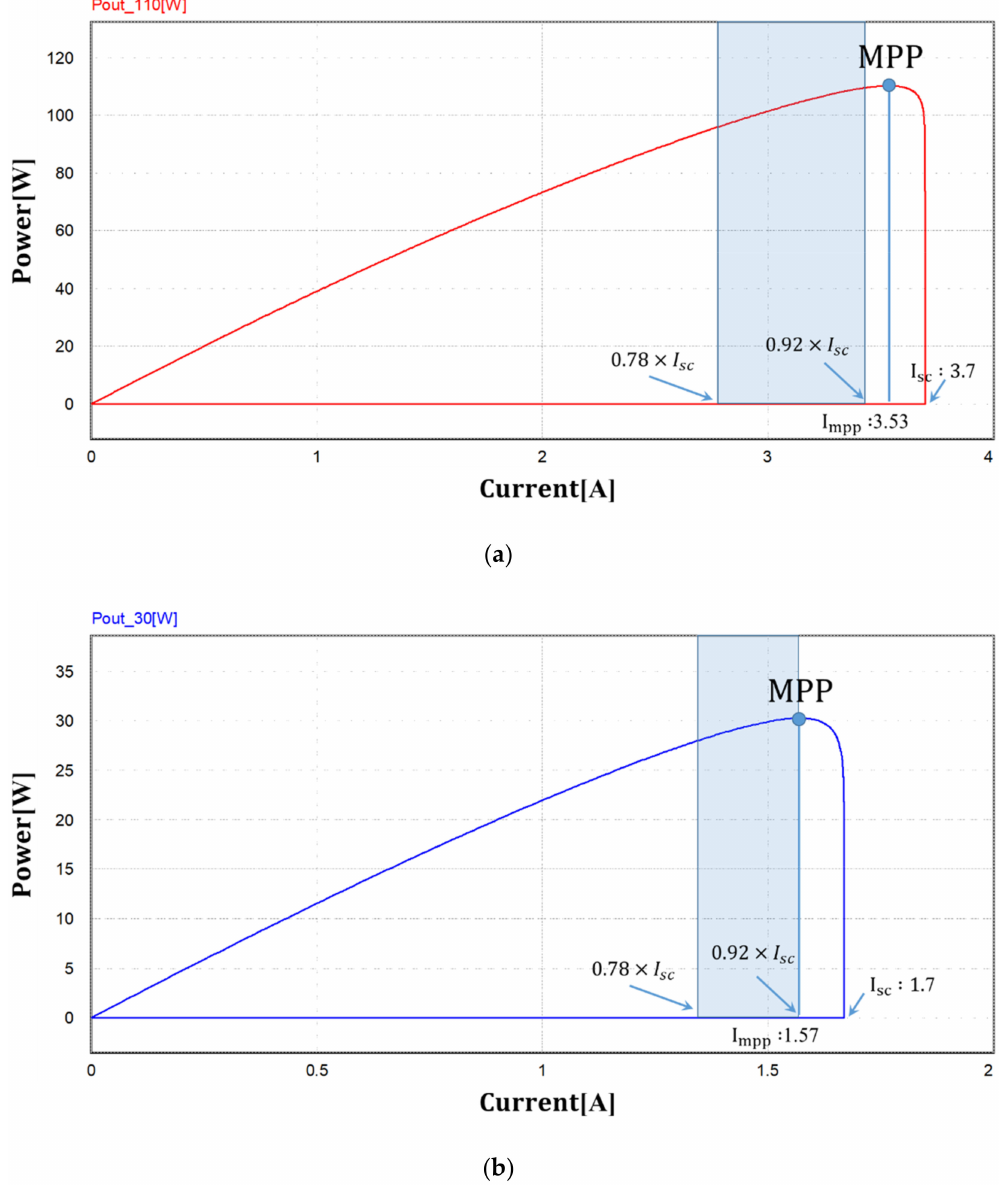
Figure 5. P-I curve of PV module. ( a ) PV module: 110 Wp; ( b ) PV module: 30